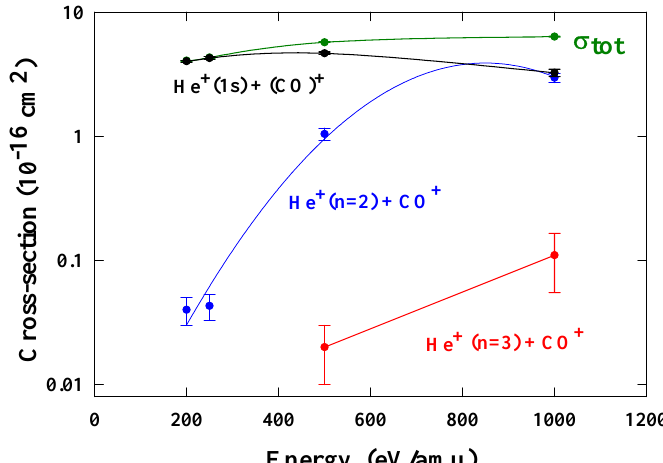
Figure 10: Cross sections for one electron capture by He 2+ ions in CO. The present data are normal- [28]. ized to total cross sections σ TOT